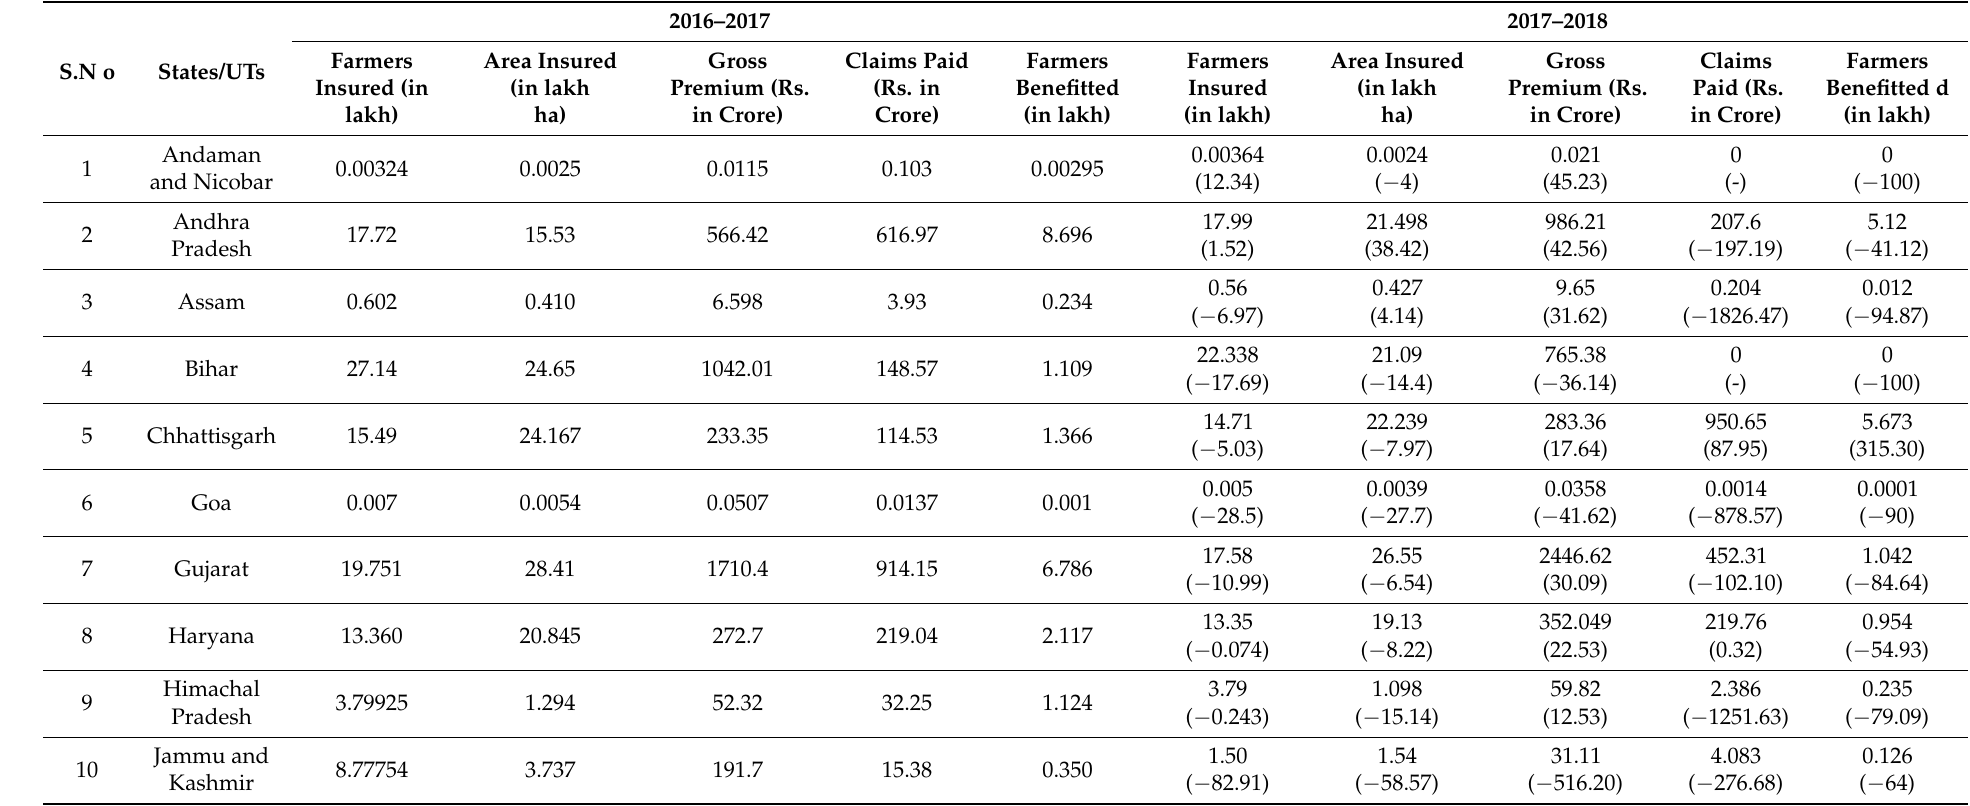
Table 3. State-wise coverage of PMFBY from 2016–2017 to